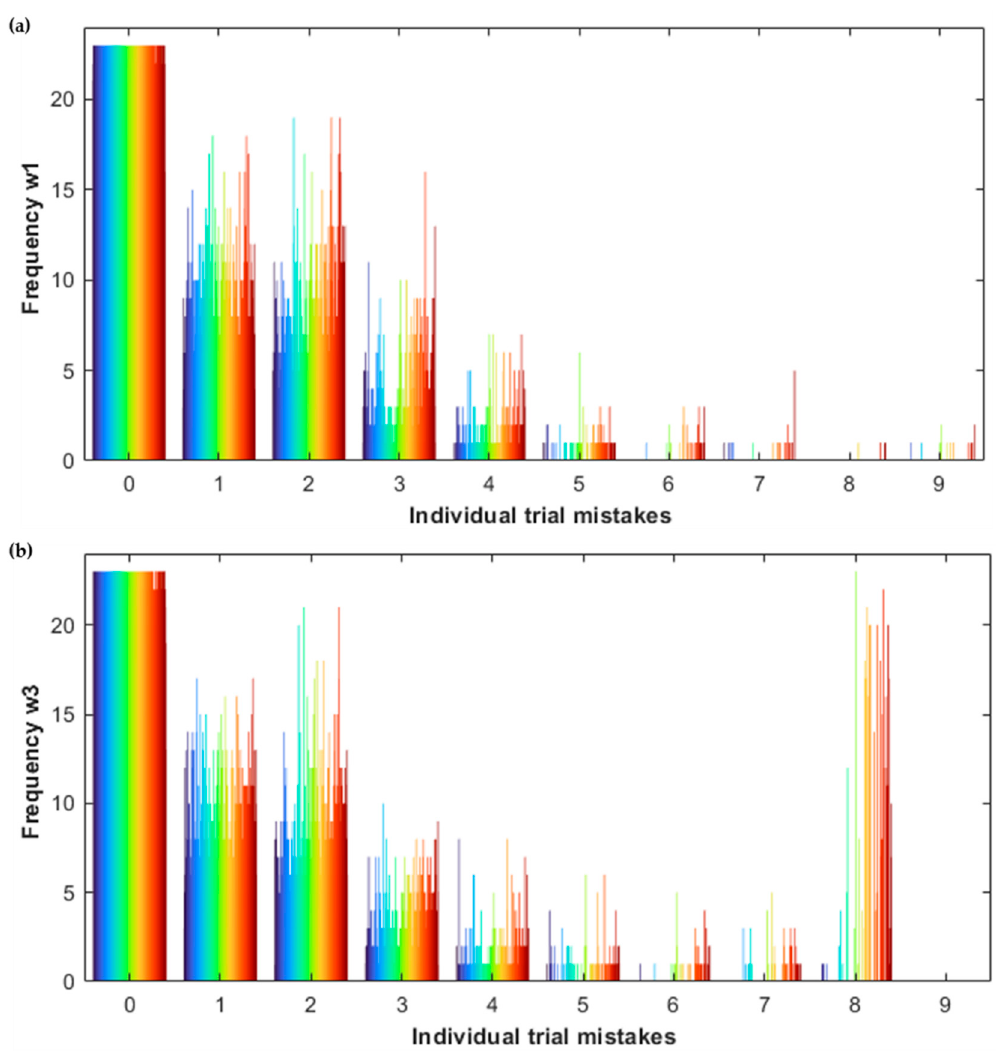
Figure 3. Histograms of distribution of individual trial mistakes at ( a ) wave 1 and ( b ) wave 3. Within each group of bars, the participants are age-sorted from left to right: 50–59 y (blue-light green), 60– 69 y (green-orange), 70 y and over (red). 60–69 year (green-orange), 70 year and over Table 2. Summary of distribution density for the individual trial mistakes at wave 1 and wave 3.